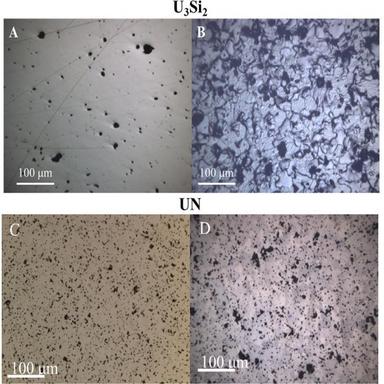
(A) The surface of the U3Si2 sample before testing in the nanoindenter. (B) The surface of the U3Si2 sample after reaching 473 K in the nanoindenter. (C) The surface of the UN sample before testing in the nanoindenter. (D) The surface of the UN sample after reaching 473 K in the nanoindenter.